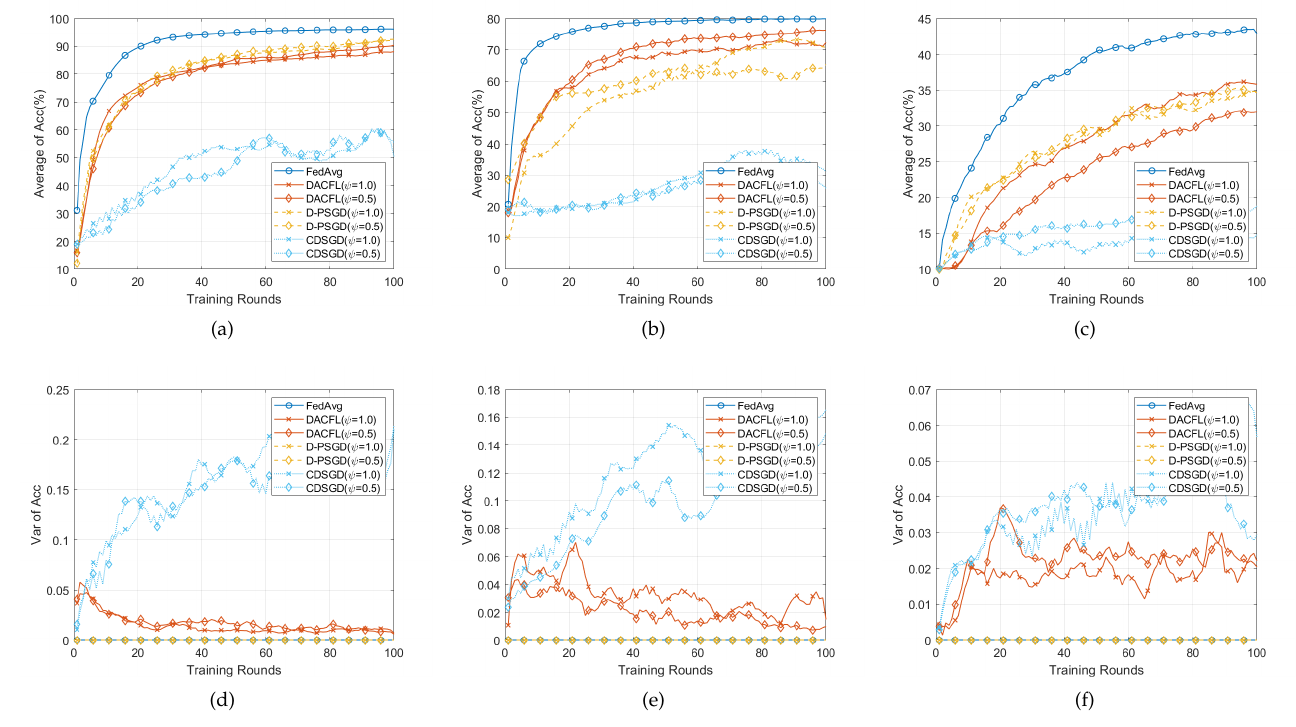
Figure 7. Performance comparison with non-i.i.d data and time-varying topology. ( a , d ) on MNIST; ( b , e ) on FMNIST; ( c , f ) on